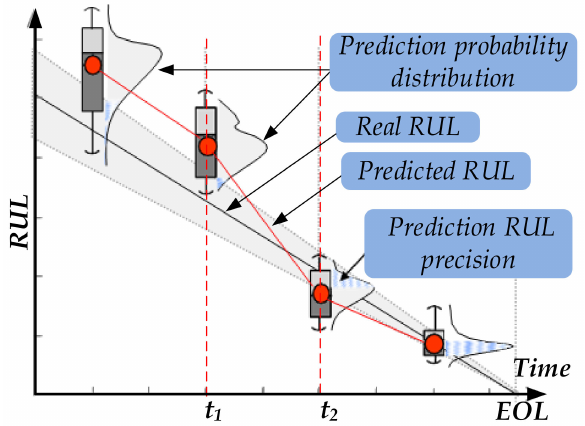
Figure 7. RUL and associated performance metrics.